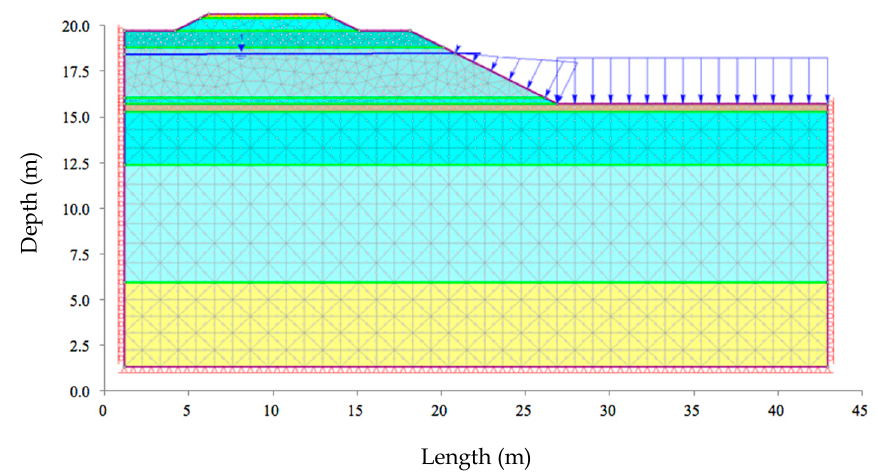
Figure 11. Water table modelling using piezometric line for base case (H C = 3.0 m, Hs = 2.95 m).